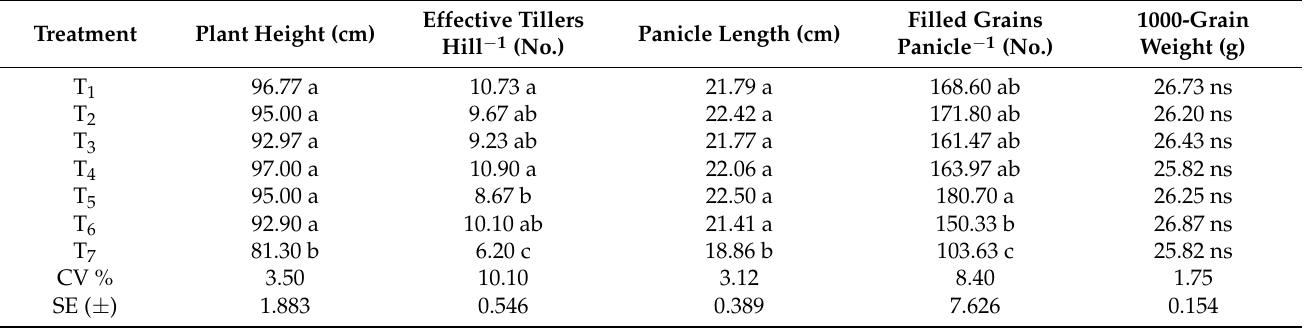
Table 1. Effect of methods of deep placement of urea fertilizer on the yield components of BRRI